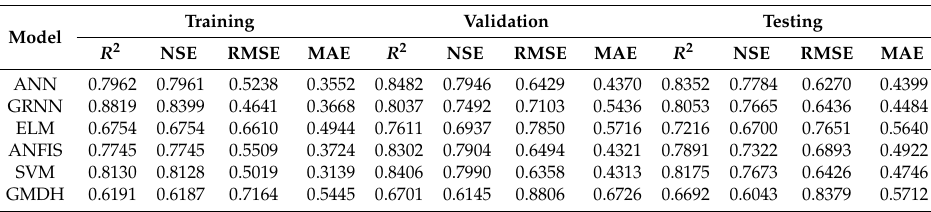
Table 5. Comparisons of data-driven models for net ecosystem exchange (NEE, g · C · m − 2 · Day − 1 ) for the training, validation and testing periods.